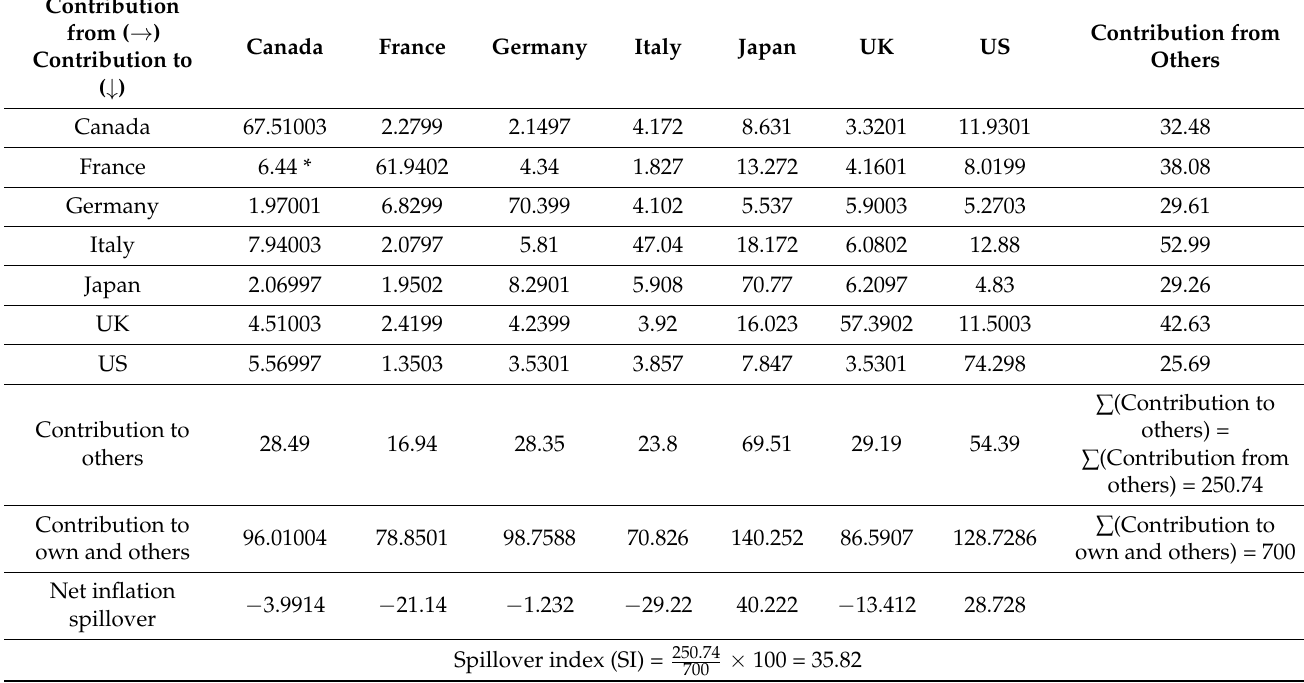
Table 2. Time-domain inflation spillover based on the Diebold and Yilmaz (2012)